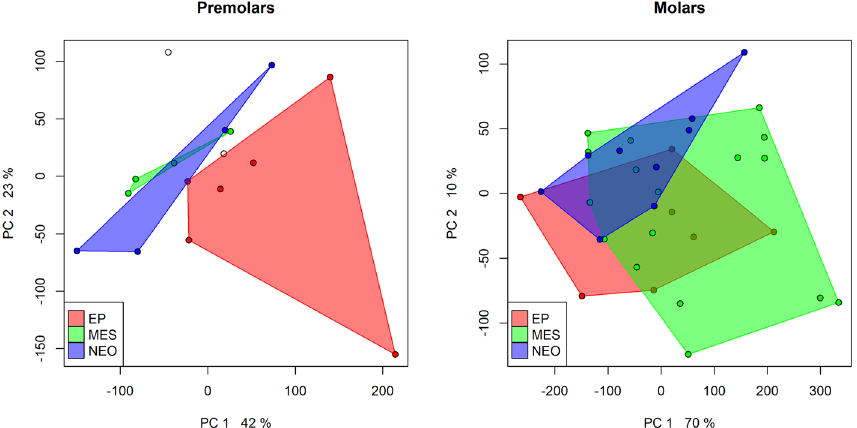
Figure 5. Scatterplots of the first and second principal component scores. Left panel third and fourth premolars only; Right panel molars only.